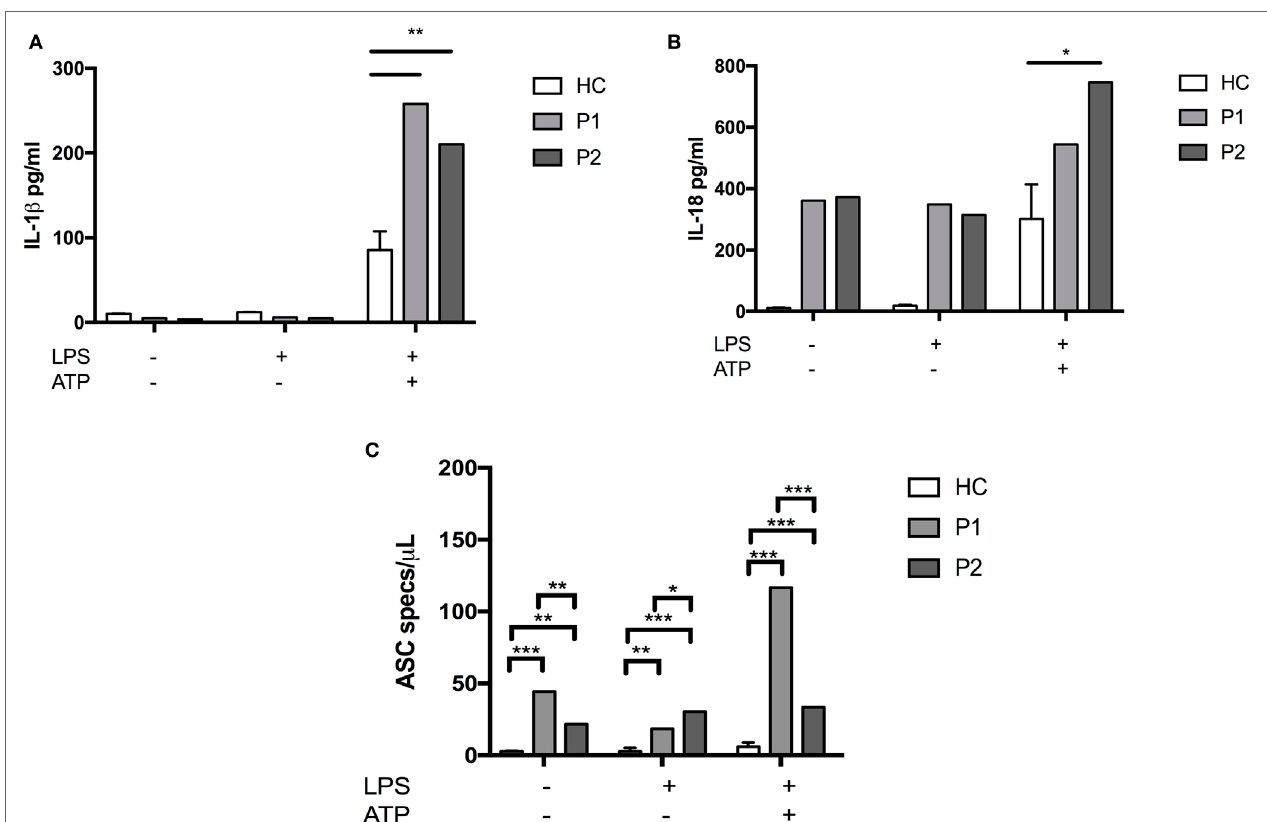
FIGURe 4 | IL-1 β , IL-18 levels, and apoptosis associated speck-like protein containing a CARD (ASC) particle numbers following stimulation of monocytes with lipopolysaccharide (LPS)/ATP. Patients’ and healthy control (HC) monocytes were seeded at 1 × 10 6 cells/mL and stimulated with LPS (10 ng/mL) (Invivogen) for 4 h and then ATP (1 mM) (Invivogen) for 30 min. Supernatants were collected and used for IL-1 β and IL-18 ELISA (ThermoFisher). The ASC particles were measured using directly conjugated anti-ASC ab (Cambridge Bioscience) and particles visualized by flow cytometry (BD LSRII). Two-way ANOVA statistical test was used ( p <